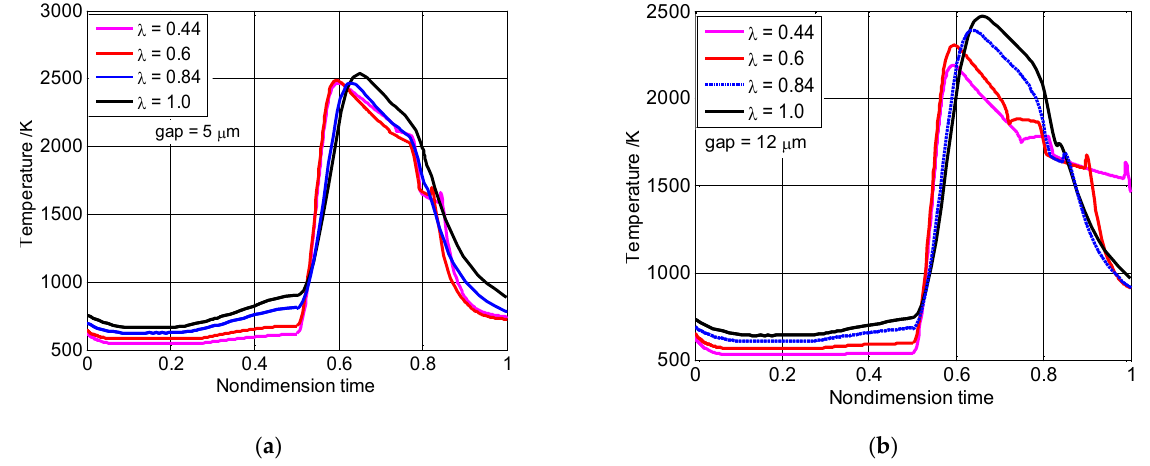
Figure 6. The influence of temperature on the nondimensional time cycle for different size factors: ( a ) the 5 μm seal gap, ( b ) the 12 μm seal gap.